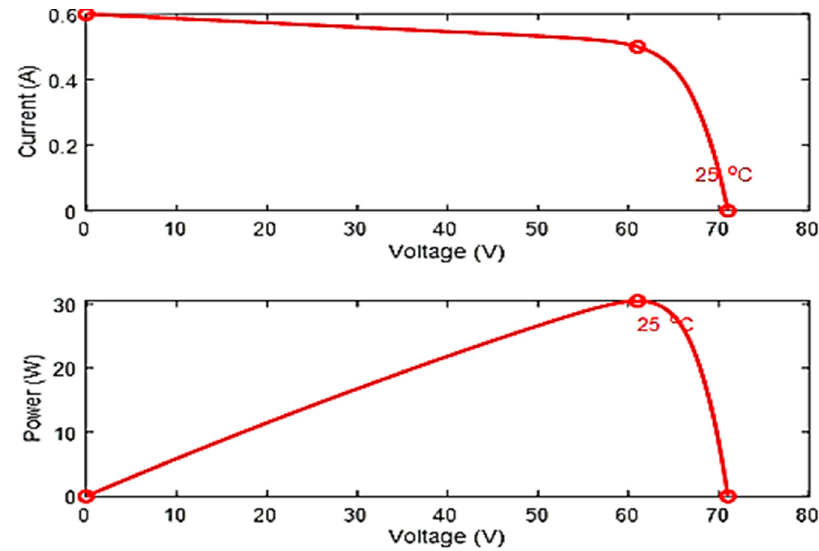
Figure 15. V-I and P-I characteristics at 25 °C.